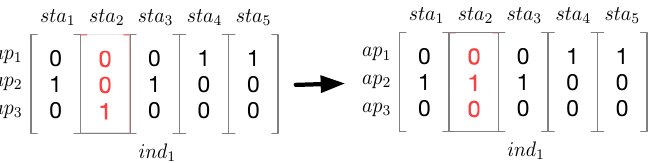
Figure 7. Mutation process. This shows the mutation of an individual, namely ind 1 . sta 3 is chosen at random to change its associated AP during